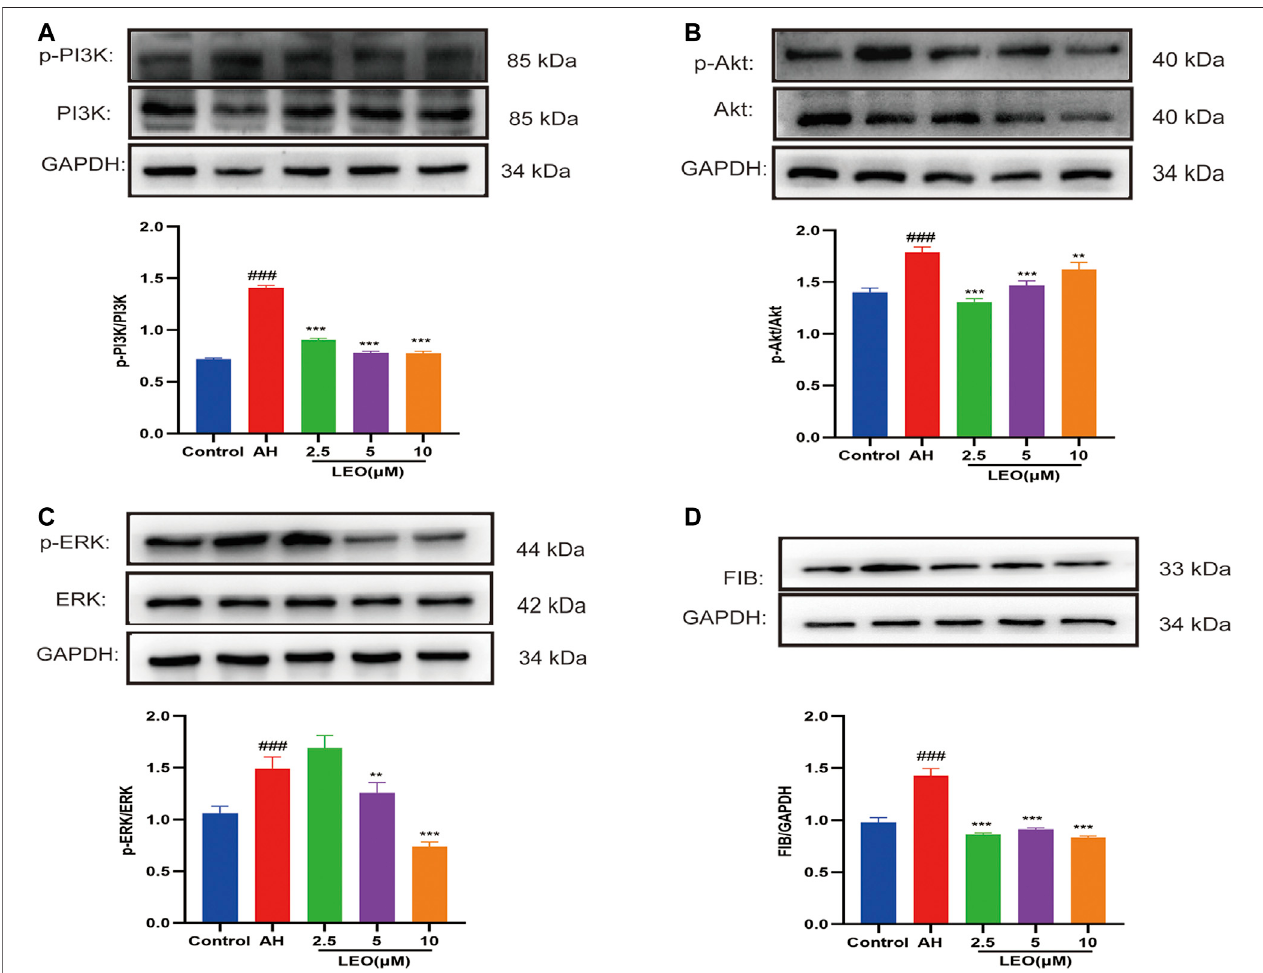
FIGURE 9 | The expression of related protein in control group, AH group and AH + LEO (2.5, 5, 10 μ M) groups. (A) The expression of PI3K and phospho-PI3K protein. (B) The expression of Akt and phospho-Akt protein. (C) The expression of ERK and phospho-ERK protein. (D) The expression of FIB protein. Data are represented by mean ± SD ( n (cid:1) 3). # p < 0.05, ## p < 0.01 , ### p < 0.001 vs Control group; * p < 0.05 , ** p < 0.01, *** p < 0.001 vs AH